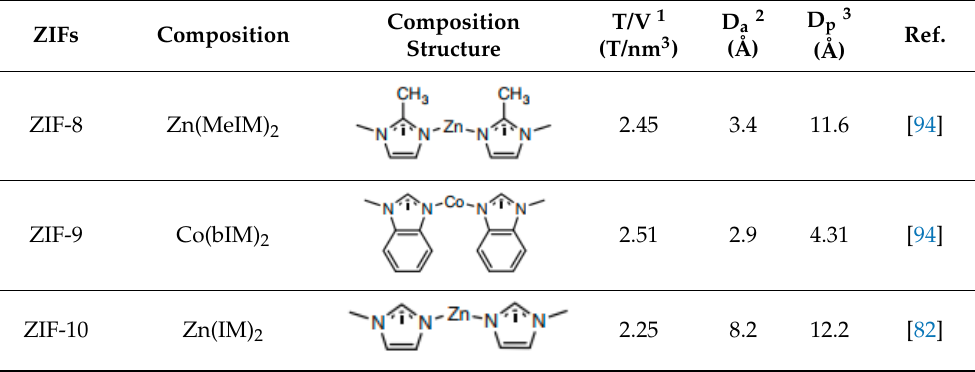
Composition Structure